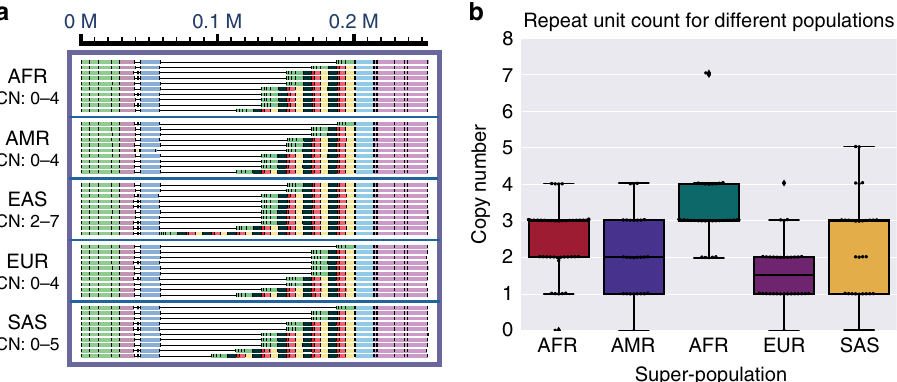
Fig. 4 Analysis of copy number variant (CNV) in pepsinogen A cluster at chromosome 11q12.2 using multiple alignment. a Visualization of CNV haplotypes using multiple alignment of contigs allows easy counting of the repeating units. Copy numbers (CNs) are shown on the left. Alignment of all individuals across the 26 populations is provided in Supplementary Fig. 13. b A boxplot for CN in different ethnic groups. East Asians (EAS) have signi fi cantly more copies than other populations ( p < 0.05, Tukey test), while Europeans (EUR) have signi fi cantly fewer copies than other populations ( p < 0.05, Tukey test) except Americans (AMR)